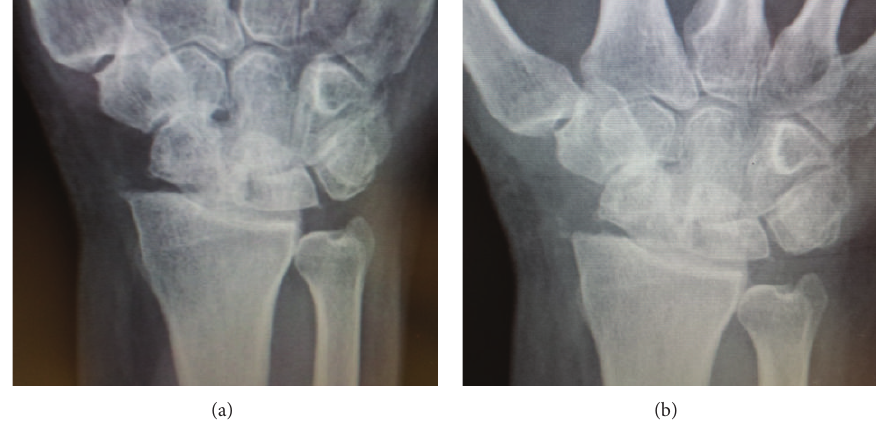
Figure 1: Preoperative appearance of wrist showing radiocarpal osteoarthritis.